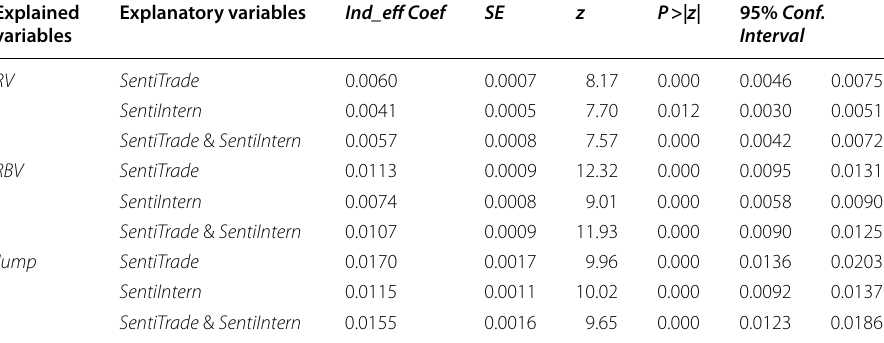
Table 8 Bootstrap testing